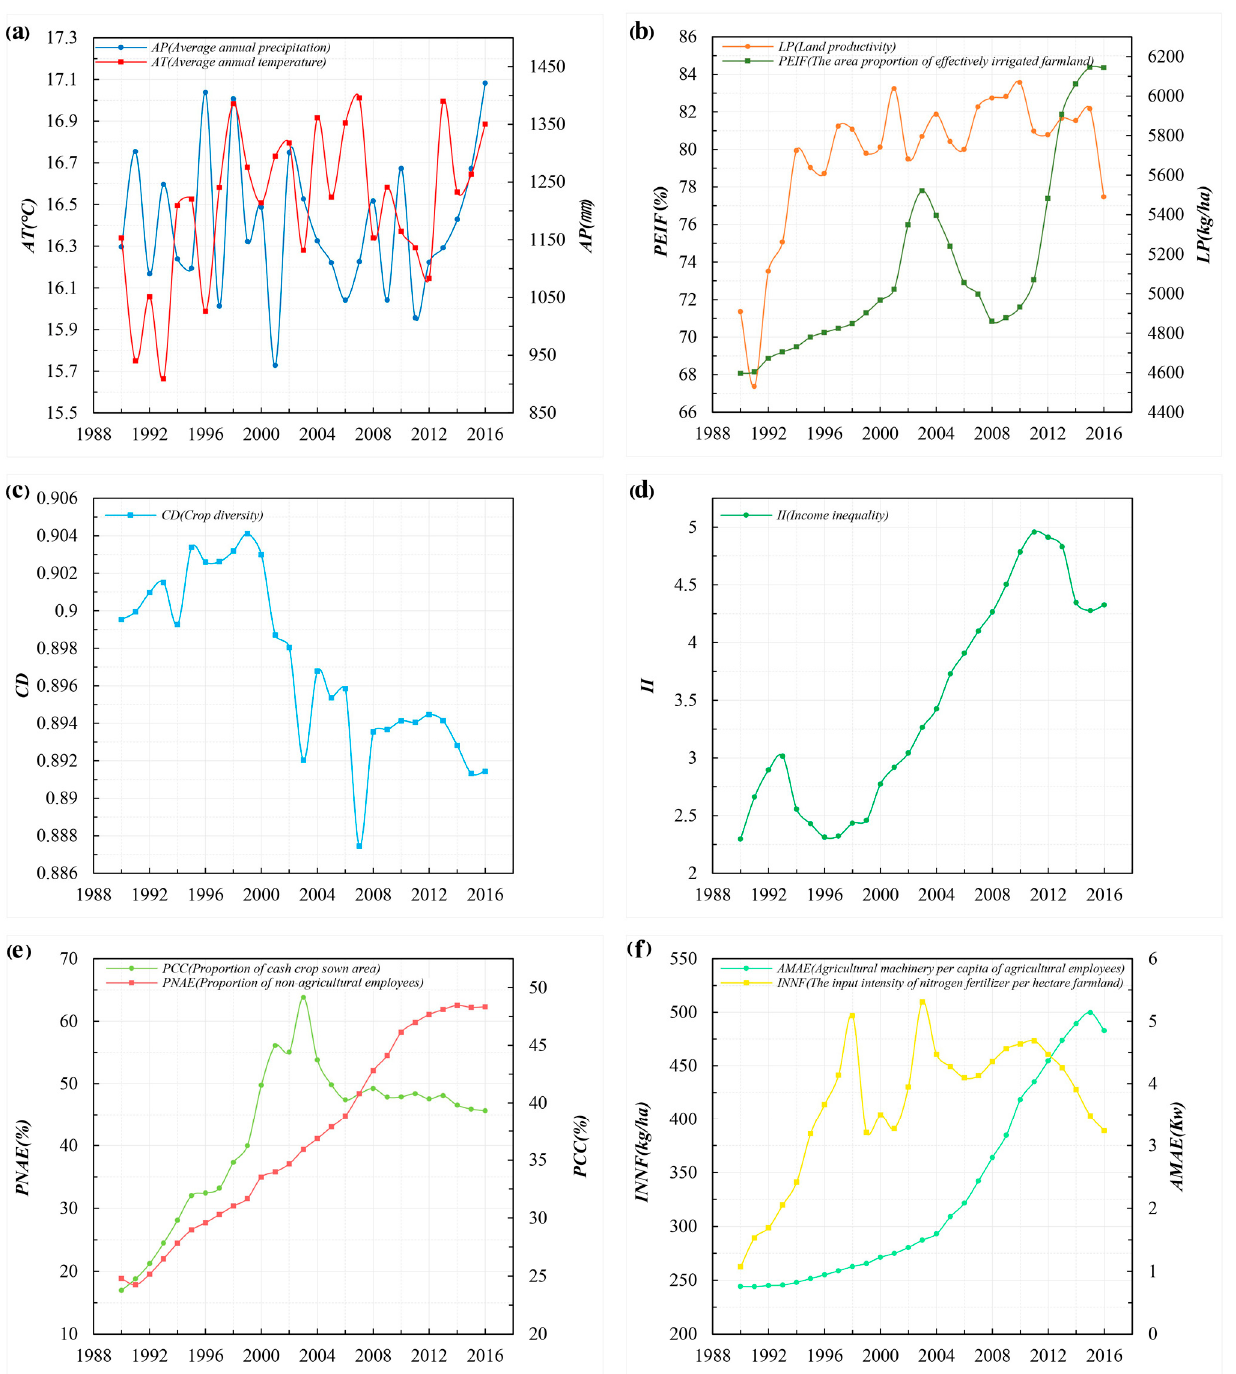
Figure 3. Changes in ( a ) average annual temperature ( AT ), average annual precipitation ( AP ), ( b ) proportion of effectively irrigated farmland area ( PEIF ), land productivity ( LP ) ( c ) crop diversity ( CD ) ( d ) income inequality (II) ( e ) proportion of cash crop sown area ( PCC ), proportion of the number of non-agricultural employees ( PNAE ) ( f ) agricultural machinery per capita of agricultural employees ( AMAE ), and input intensity of nitrogen fertilizer per hectare of farmland (INNF ) within Hubei province between 1990 and 2016. Data source: The Rural Statistical Yearbook of Hubei Province 1991–2017 and the Hubei Statistical Yearbook 1991–2017.